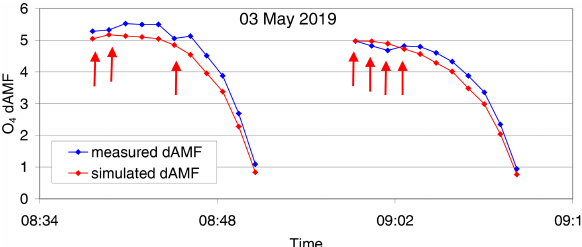
Figure A13. Comparison of the measured and simulated O 4 dAMFs for two elevation sequences on 5 March 2019. For the first elevation se- quence, the AOD was < 0.05 at 360nm. During the second elevation sequence, it already increased to 0.06. The radiative transfer simulations were made for an aerosol-free atmosphere. The red arrows indicate cloud-contaminated measurements.